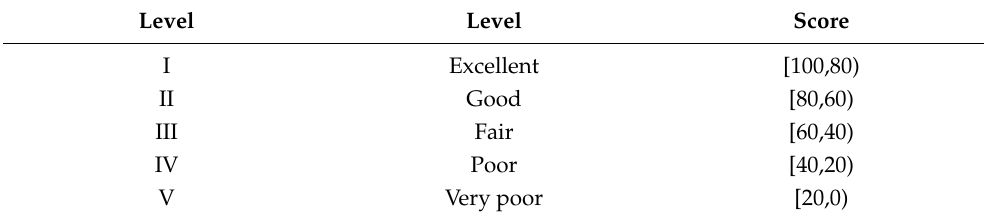
Table 2. Scoring levels and corresponding values. Level Level